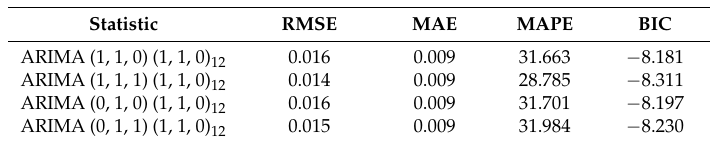
Table 4. Goodness of fit statistics for plausible autoregressive integrated moving average (ARIMA) models for the prediction of influenza.